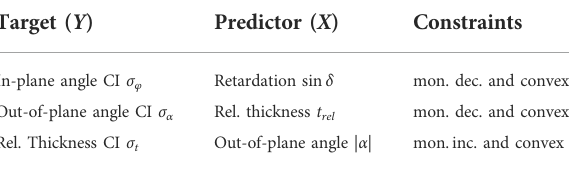
TABLE 1 Table of target ( Y ) and predictor ( X ) variables with assumed constraints as they are observed from Figure